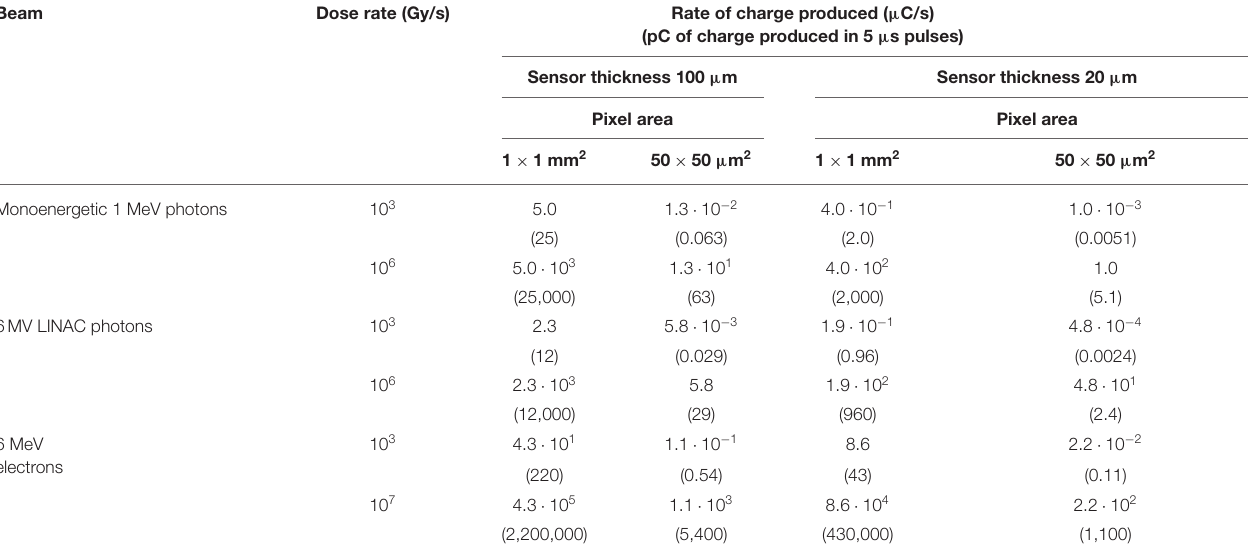
TABLE 2 | Rate of charge production and total charge produced in a pulse of 5 µ s (in parenthesis) in the detector element for different beams, dose-rates, pixel area, and sensor thickness.